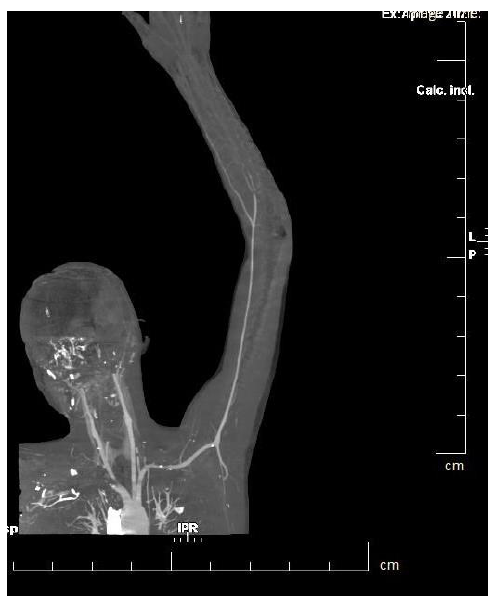
Figure 1. CT angiography of left subclavian artery, Compression of left subclavian artery by anterior scalene